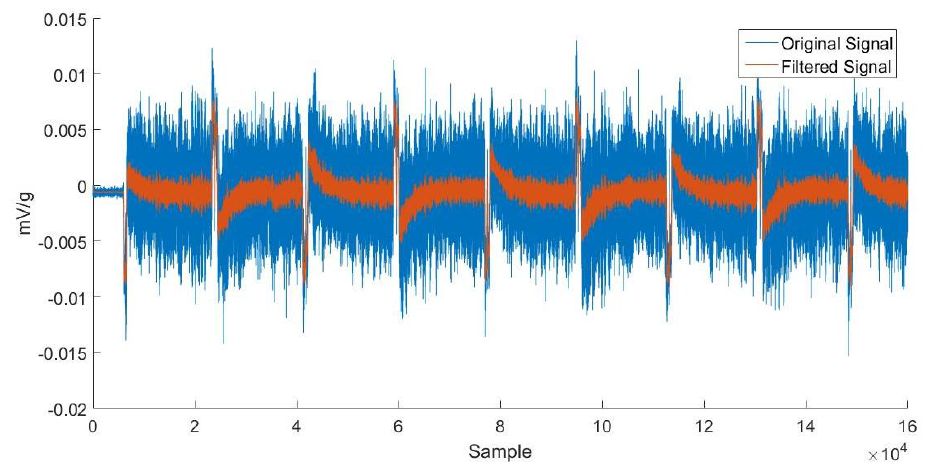
Figure 10. Partial view of the original vibration signal ( blue ) and signal profile after Kalman filtering ( red ).